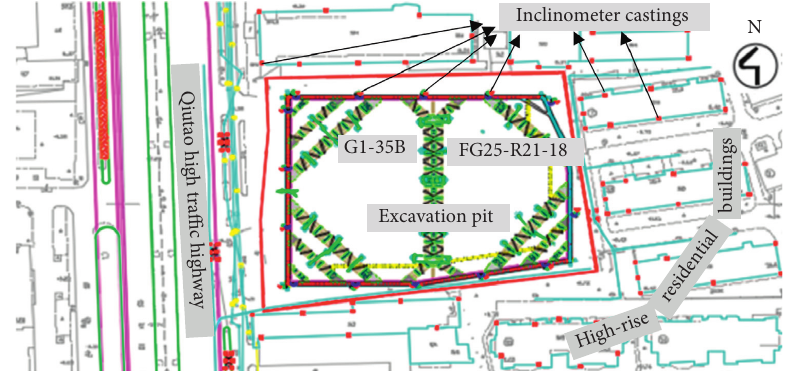
Figure 19: Triumph Unit project plan view showing the excavation pit, surrounding environment, and the inclinometer points for monitoring purpose.